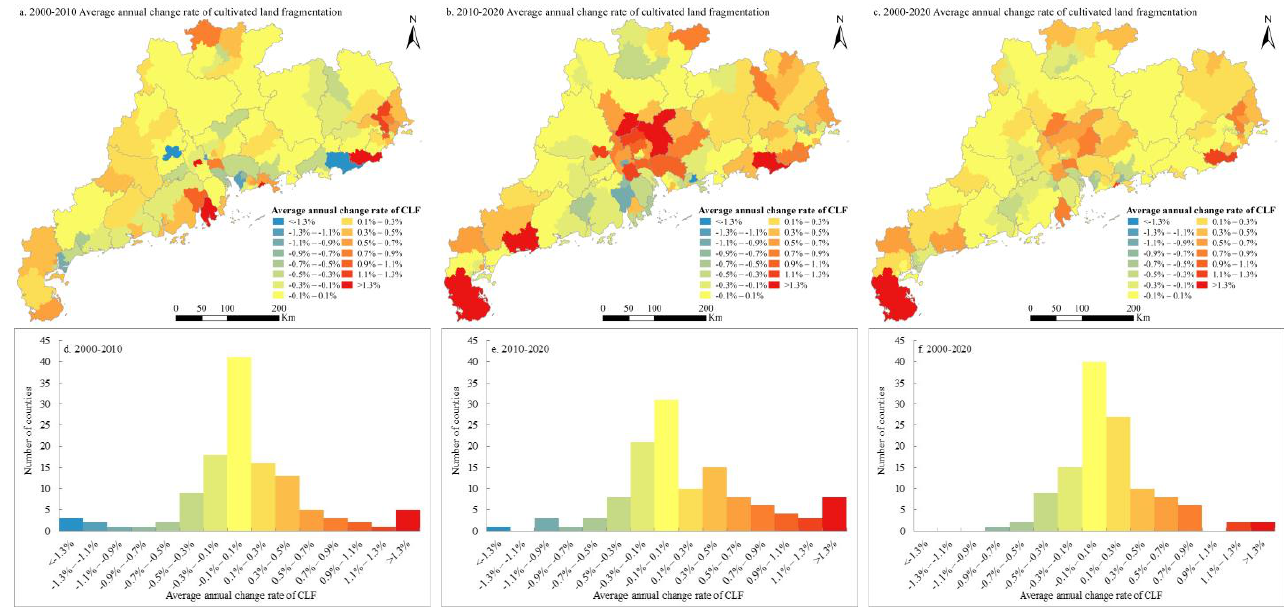
Figure 8. Average annual change rate of CLF and its spatial distribution in Guangdong Province on the county scale during 2000 – 2010, 2010 – 2020, and 2000 – 2020. The spatial distribution and histogram of the average annual change rate of CLF during 2000 – 2010 are displayed in ( a , d ), respectively. The spatial distribution and histogram of the average annual change rate of CLF during 2010 – 2020 are displayed in ( b , e ), respectively. The spatial distribution and histogram of the average annual change rate of CLF during 2000 – 2020 are displayed in ( c , f ), respectively. Colors in the histograms correspond with the maps.